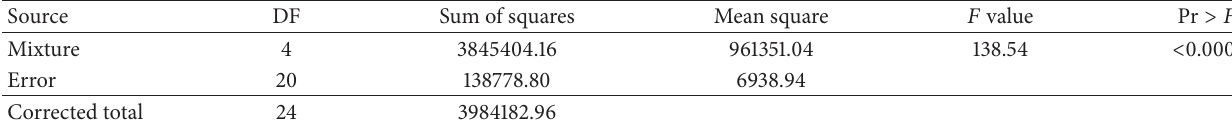
Table 6: Analysis of variable result for dynamic